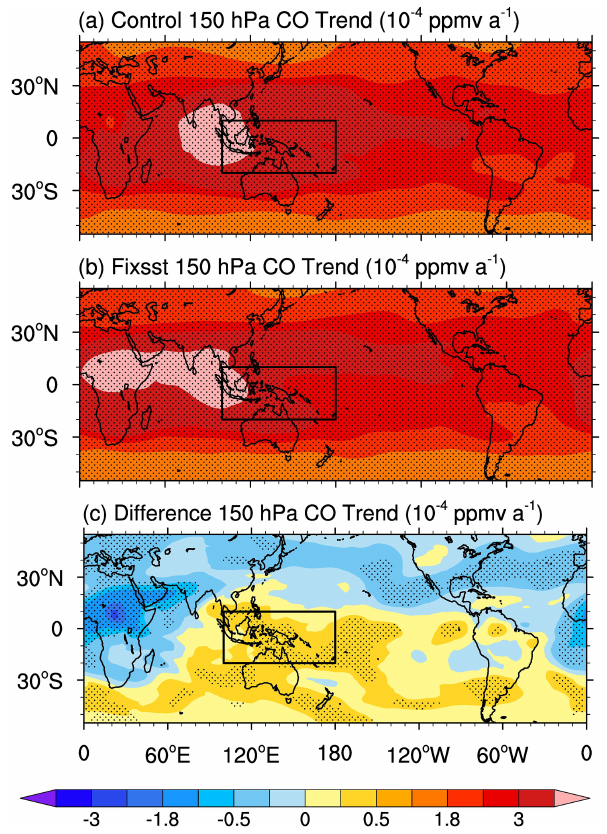
Figure 9. The trends of 150hPa CO concentration (10 − 4 ppmva − 1 ) from the (a) Control simulation, (b) Fixsst simulation, and (c) difference between the Control simulation and the Fixsst simulation in NDJFM during 1958–2017. The trends in panels (a) – (c) over the dotted regions are statistically significant at the 95% confidence level. The black rectangles denote the TWP region (20 ◦ S–10 ◦ N, 100–180 ◦ E).